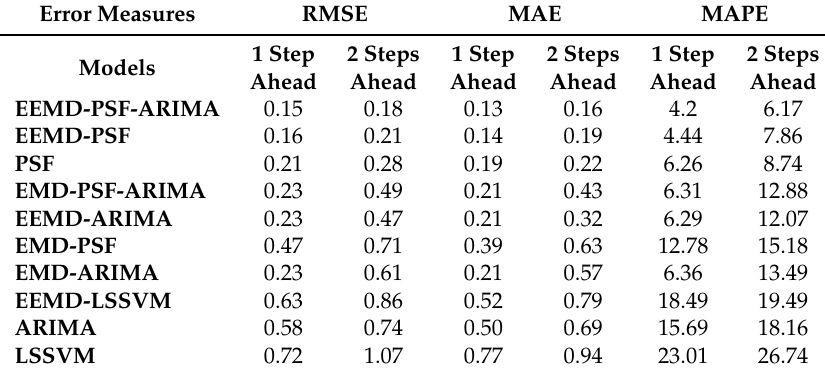
Table 9. Comparison of proposed methods with reported methods on RMSE, MAE and MAPE for one and two step ahead (iterate strategy) forecasting with wind speed time-series.